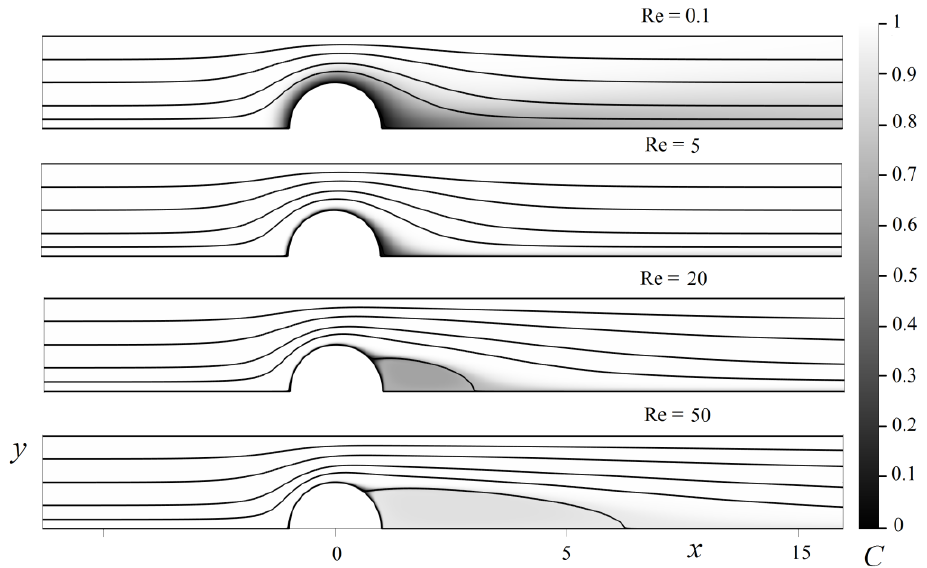
Figure 5. The flow and concentration C fields past a row of fibers at different values of the Reynolds number, where Sc = 1000, a / h = 0.5, and the streamline inlet ordinates are 10 − 4 , 0.2, 0.5, 1, and 1.5.